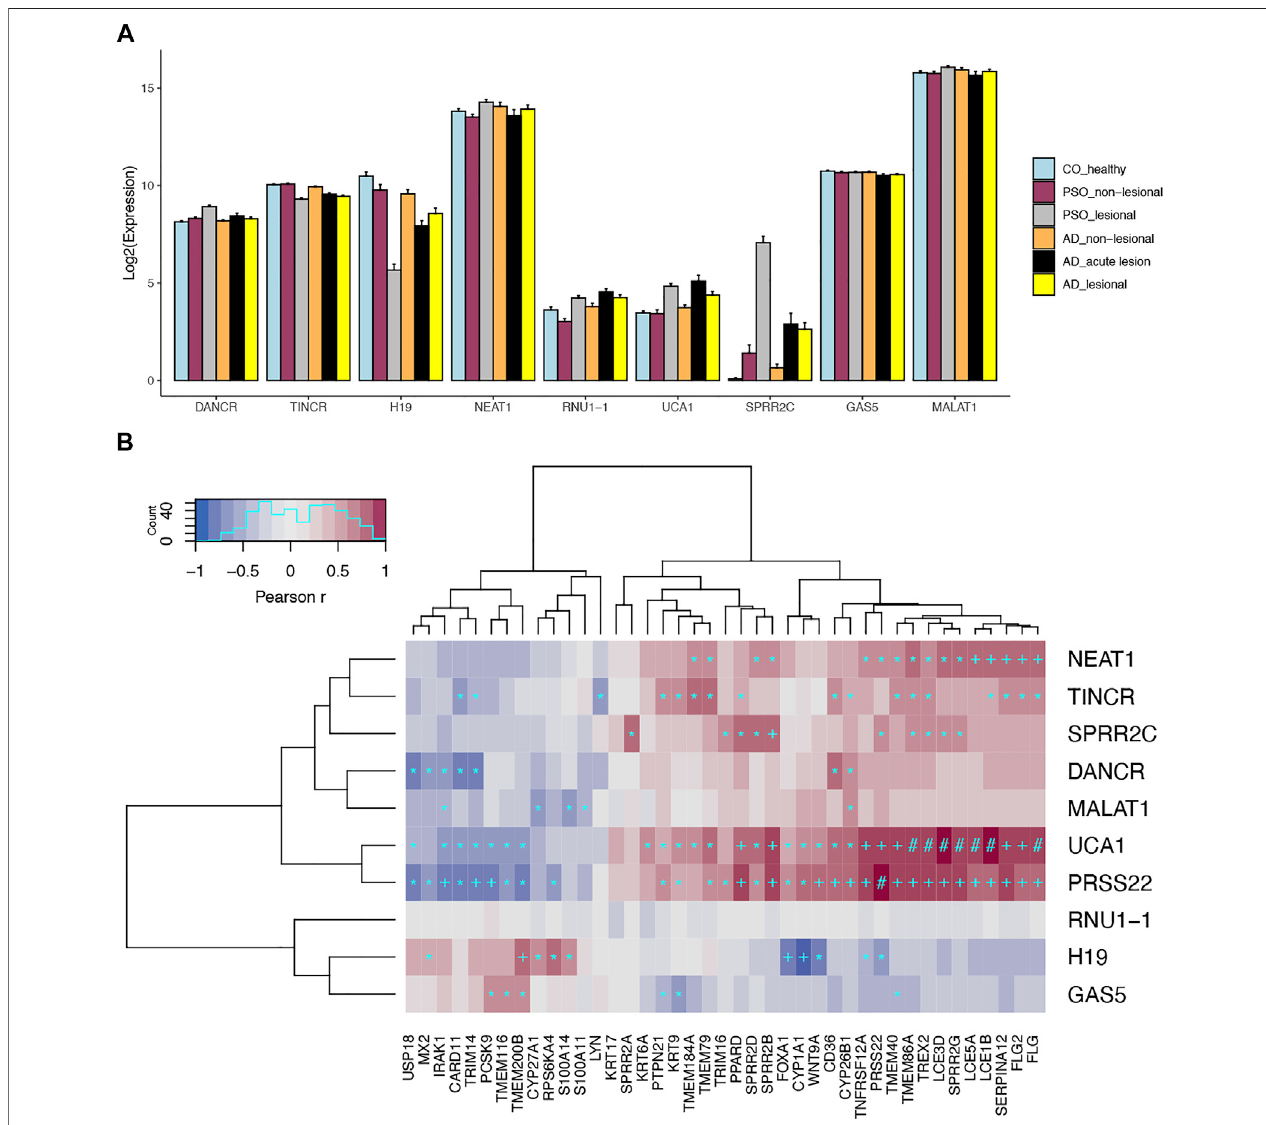
FIGURE 1 | Expression pro fi les for skin-expressing lncRNAs. (A) Gene expression pro fi les for prominent skin-expressing lncRNAs in different disease conditions. (B) Top most correlated protein-coding genes for skin-expressinglncRNAs. Heatmap shows the spearman correlation in keratinocytes. * p < 1x10 − 20 ; + p < 1x10 − 50 ; # p < 1x10 − 100